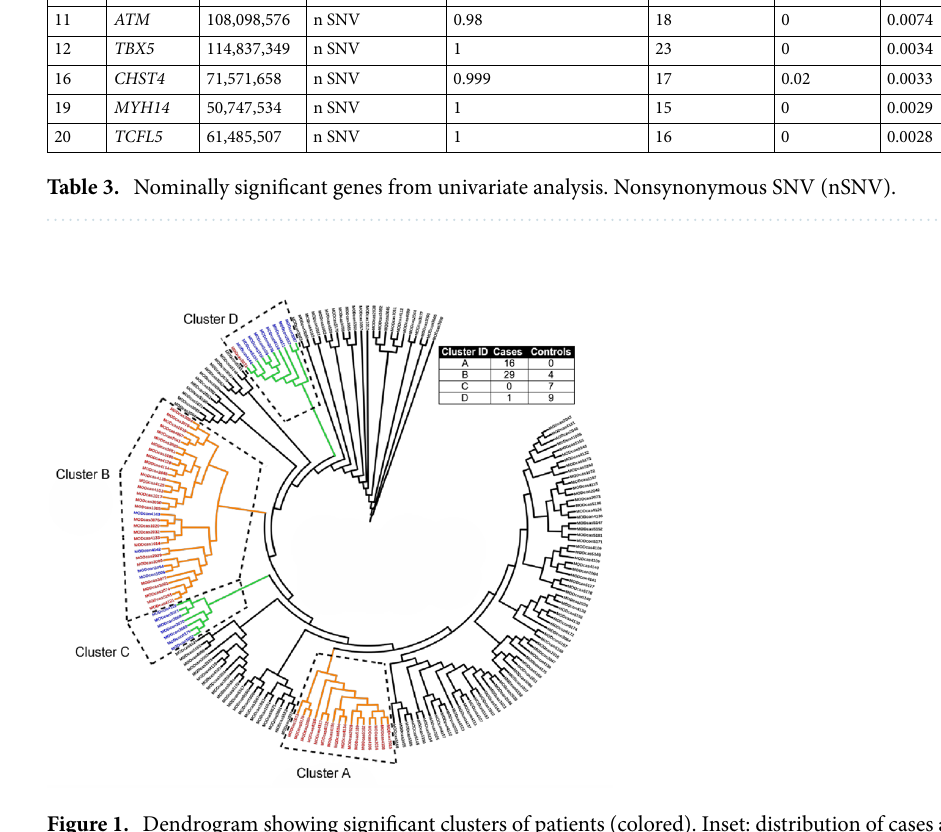
Figure 1. Dendrogram showing significant clusters of patients (colored). Inset: distribution of cases and controls in each of the